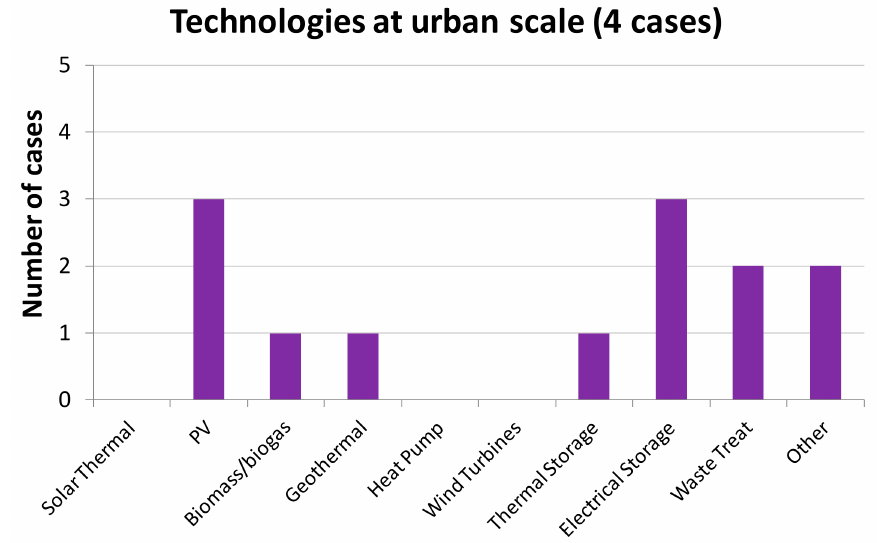
Figure 16. Histogram of occurrence obtained for the technologies installed at the urban